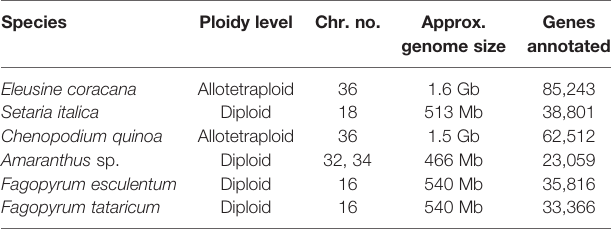
TABLE 8 | Details of important QTLs/genes linked with accumulation of nutritional/anti-nutritional factors in underused crops.